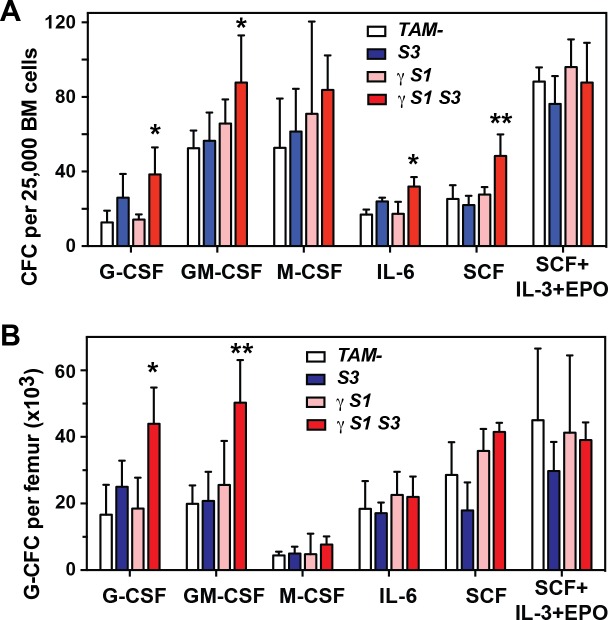
Hematopoietic colony formation by bone marrow cells from mice lacking SOCS proteins.Total number (A) or number of granulocyte (B) colonies in agar cultures of bone marrow cells from mice 14d after tamoxifen or vehicle treatment. Cultures were stimulated with G-CSF, GM-CSF, M-CSF, IL-6, SCF or the combination of SCF, IL-3 and EPO. Mean ± SD is shown with * p<0.05 for comparison of γS1S3 with TAM- and γS1 but not S3, ** p<0.05 for comparison of γS1S3 with all other genotypes, one-way ANOVA with Tukey’s multiple comparisons test, n = 3–4 mice per group.